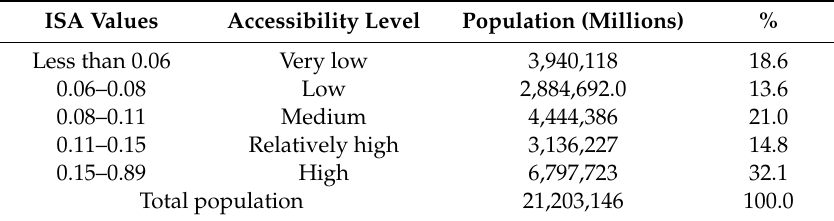
Table 3. Population share by levels of hospital